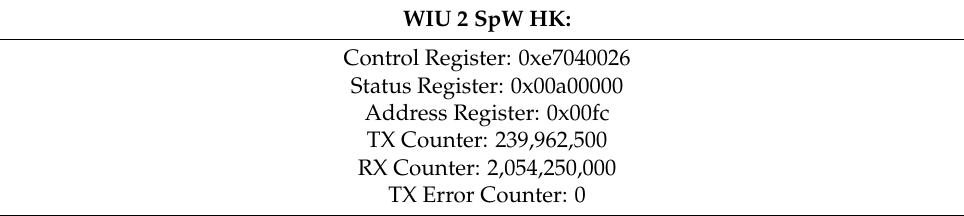
Table 9. Received SpW Housekeeping Data from WIU Node via WIU